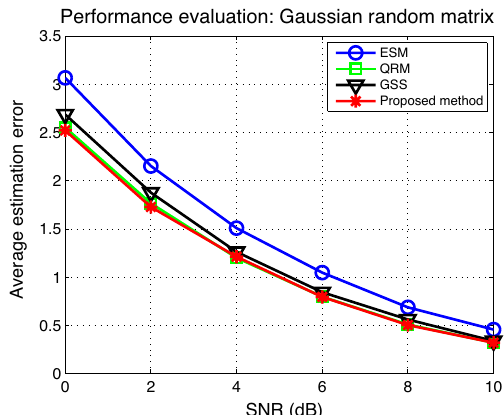
Fig. 4 Performance investigation with respect to SNR for Gaussian random matrix H : the various sensor selection algorithms with | S | = p = 30 are evaluated by varying the SNR